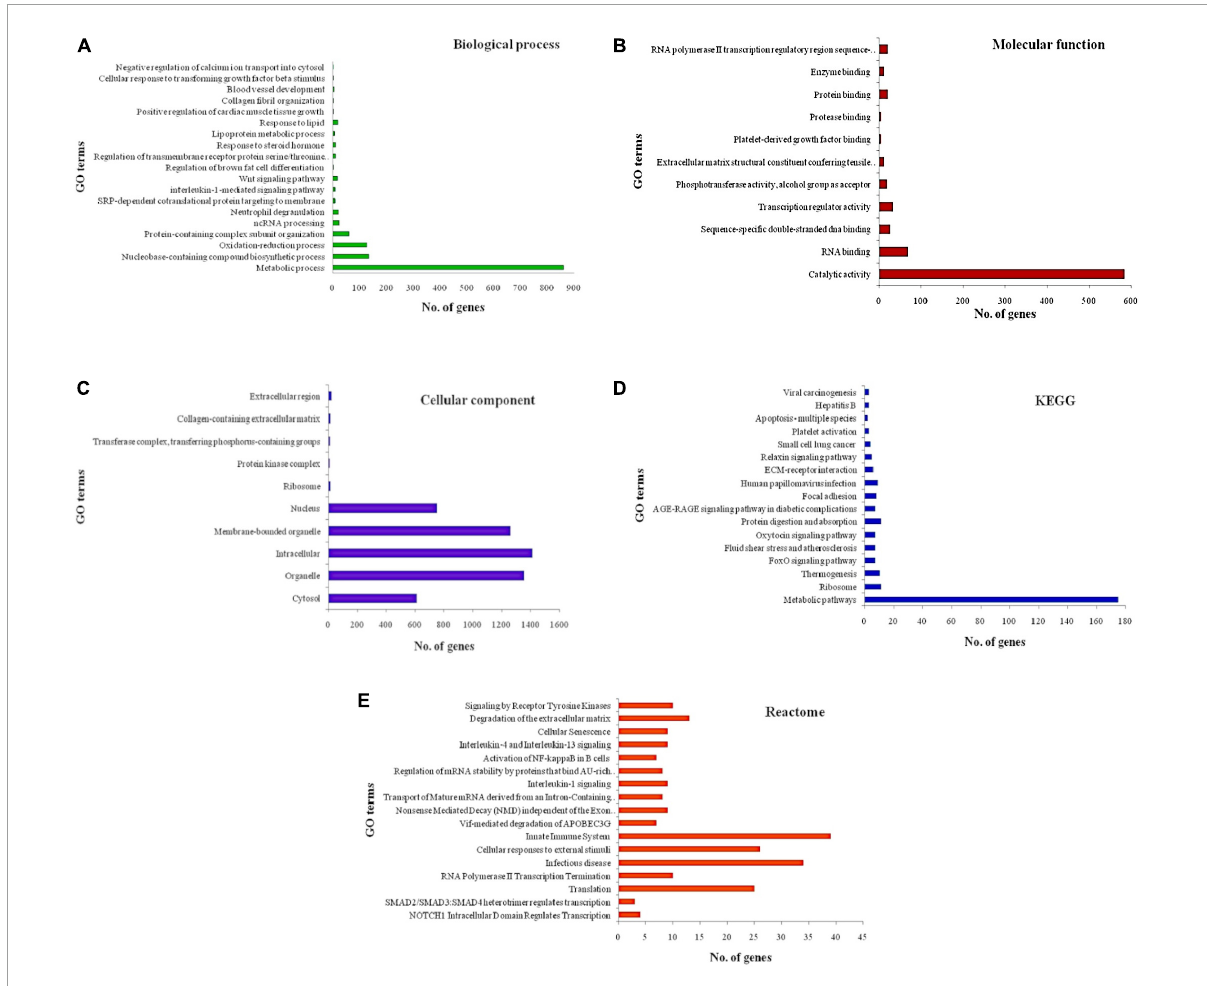
FIGURE2 Significantly enriched gene ontology terms for the predicted targets (A) biological process (B) molecular function (C) cellular component (D) KEGG pathways (E) reactome pathways. X-axis represents the number of genes associated with each gene ontology (GO) term and Y-axis represents GO terms. Longest bar indicates the highest number of genes associated with the GO term and shortest bar indicates the least number of genes associated with the GO